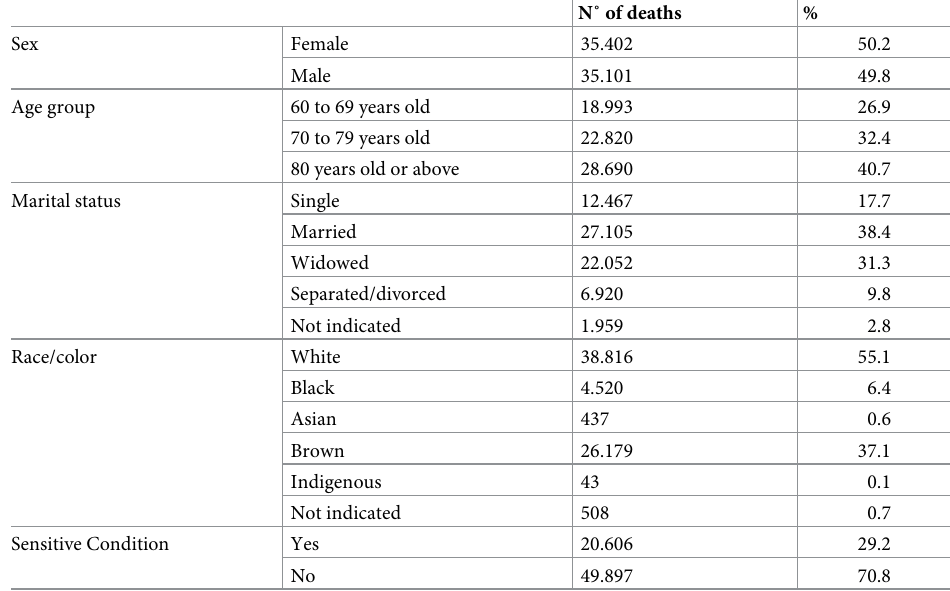
Table 1. Distribution of deaths of the elderly according to sociodemographic characteristics and ambulatory care sensitive conditions. Federal District, Brazil, 2008 to 2018.